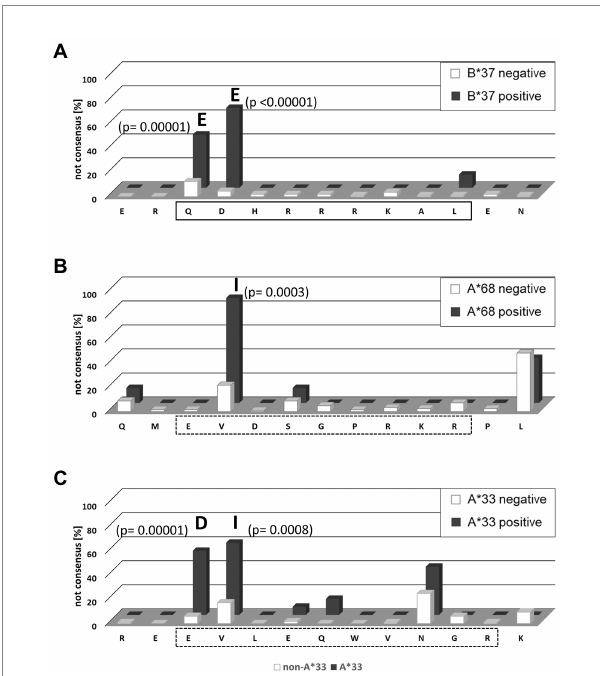
FIGURE 4 Frequency of HLA-associated viral polymorphisms in the epitope region predicted by the HAMDetector. The frequency of variations from the prototype sequence of the epitope region are shown for patients carrying the corresponding HLA-allele (black) and patients not carrying the corresponding HLA-allele (white). Positions with significant differences in polymorphism frequencies in the absence or presence of the corresponding HLA-molecule are marked, and p values (Fisher exact test) and the most frequent variant amino acid are indicated. (A) HLA-B*37 epitope region aa98–110. The confirmed epitope is outlined. (B) HLA-A*68 epitope region aa78– 90. The predicted epitope is outlined in dashed lines. (C) HLA-A*33 epitope region aa13–25. The predicted epitope is outlined in dashed